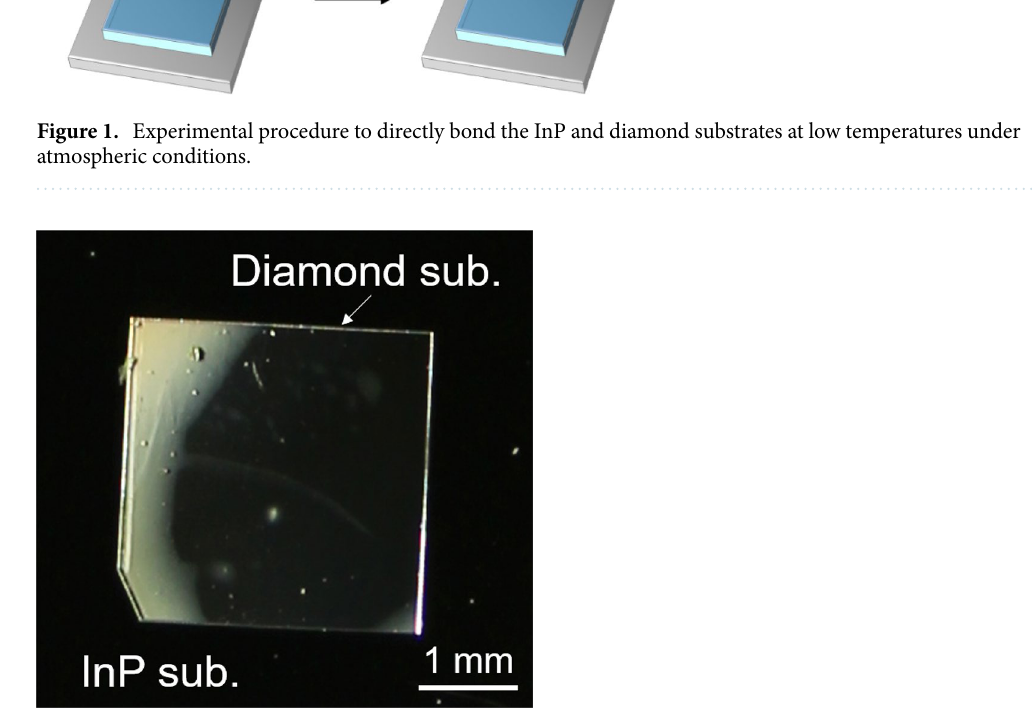
Figure 2. Diamond substrate bonded on the InP substrate. Bright areas are due to unbonded areas at InP/ diamond